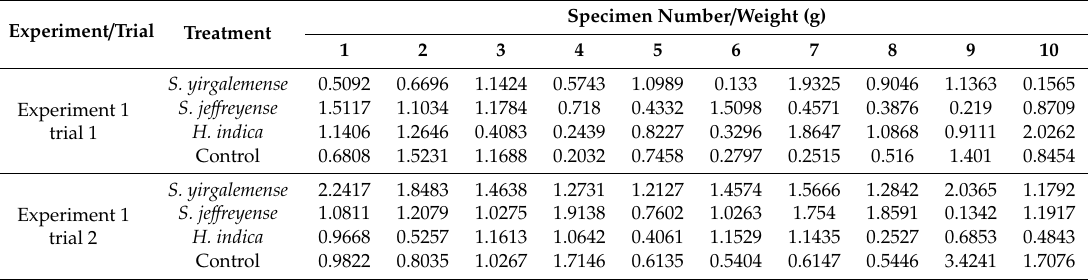
Table 1. Weight (g) of the Cacosceles newmannii larvae used for experiments 1, 2, 4, 5 and as control, as an indication of the size range of the larvae